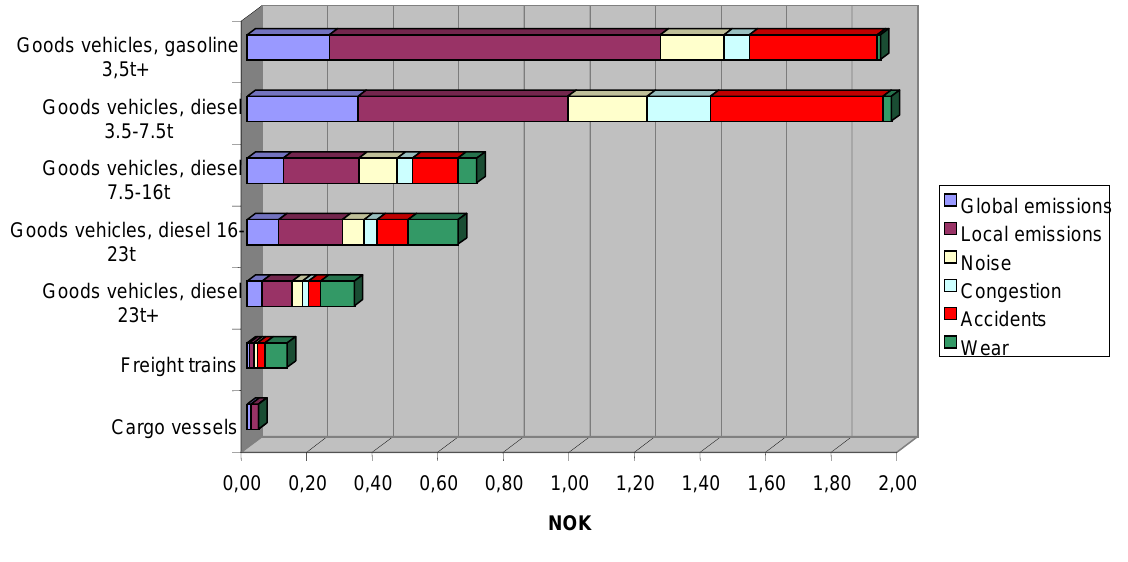
Figure 2. Marginal external costs per